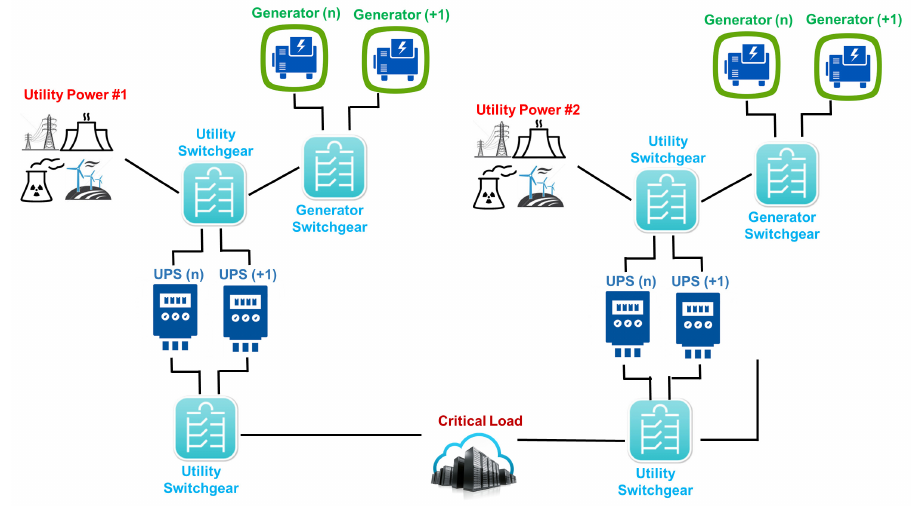
Figure 4. Tier IV power system from utility to IT equipment.